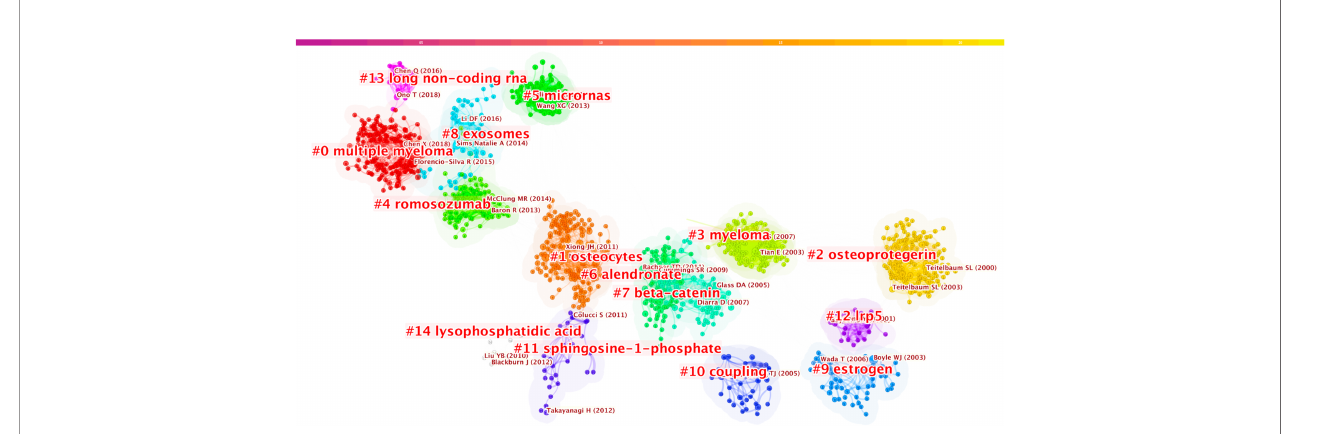
FIGURE 8 | Keywords clustering of co-cited references in osteoblasts-osteoclasts in bone disease. Notes: The size of nodes represents the co-occurrence frequency of co-cited studies, and different colors represent different clustering